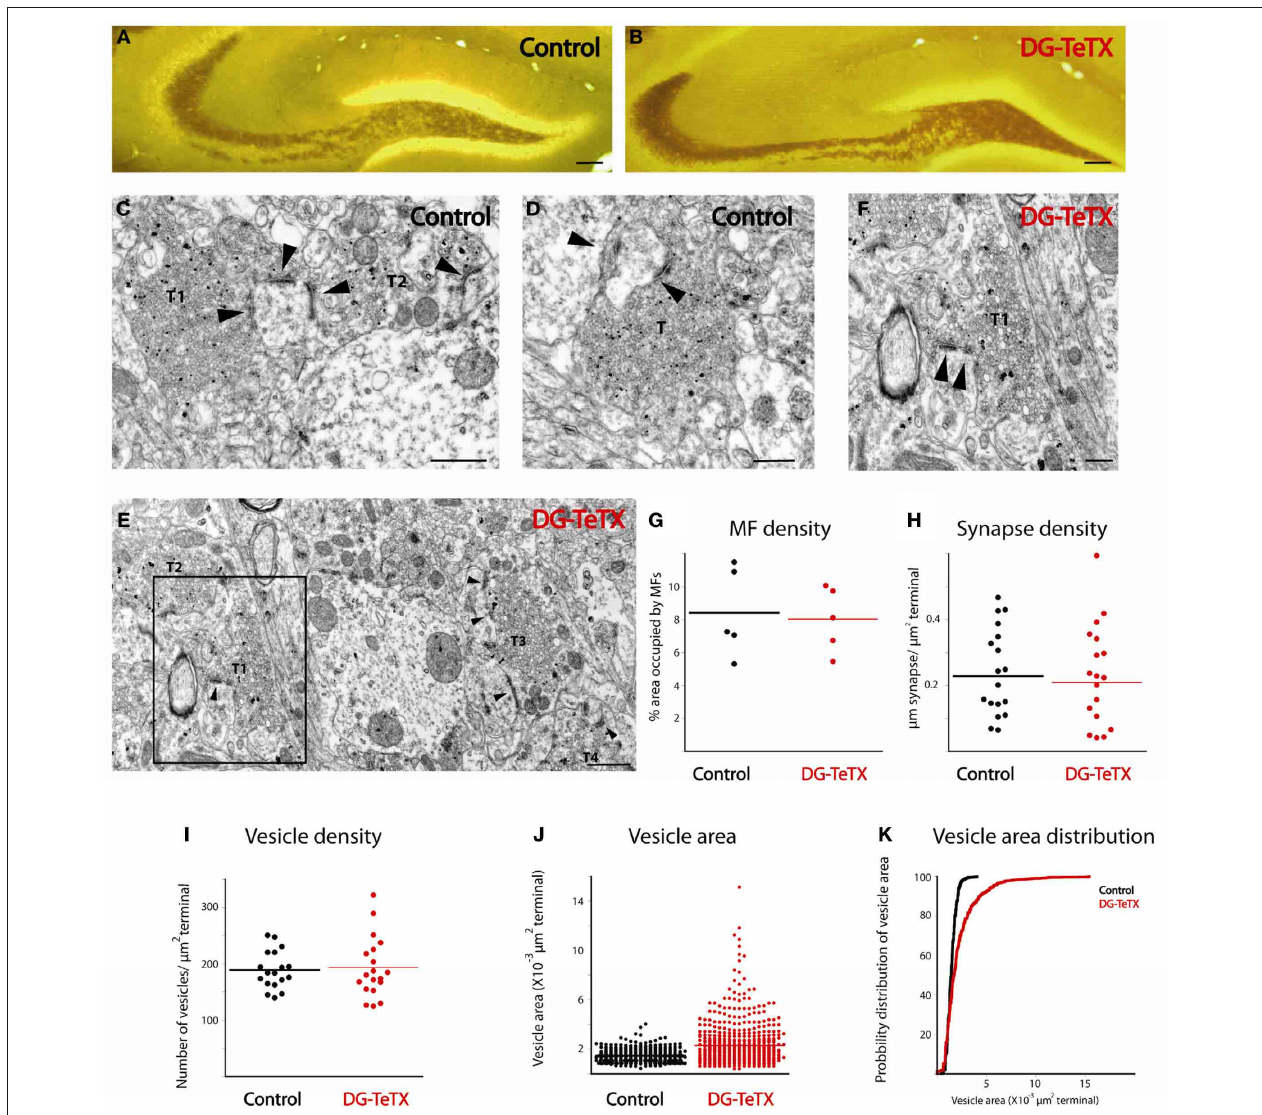
FIGURE 3 | Ultrastructural comparison of active and silenced MF terminals. (A,B) Mossy fiber tracks in representative sections from control (A) and DG-TeTX (B) mice are labeled with neoTimm staining. (C–F) Representative electron micrographs demonstrate that mossy fiber terminals (T) form multiple synaptic contacts (arrowheads) with their postsynaptic targets in control (C,D) and in DG-TeTX (E,F) mice. Zinc-labeled terminals (T1–T3) are abundant in the stratum lucidum of DG-TeTX samples (E) , T1 is shown in panel F at higher magnification where the high degree of variability in vesicle size is clearly evident. (G) The density of mossy fibers measured as a ratio of the percentage of surface area covered by zinc-positive large presynaptic specializations was